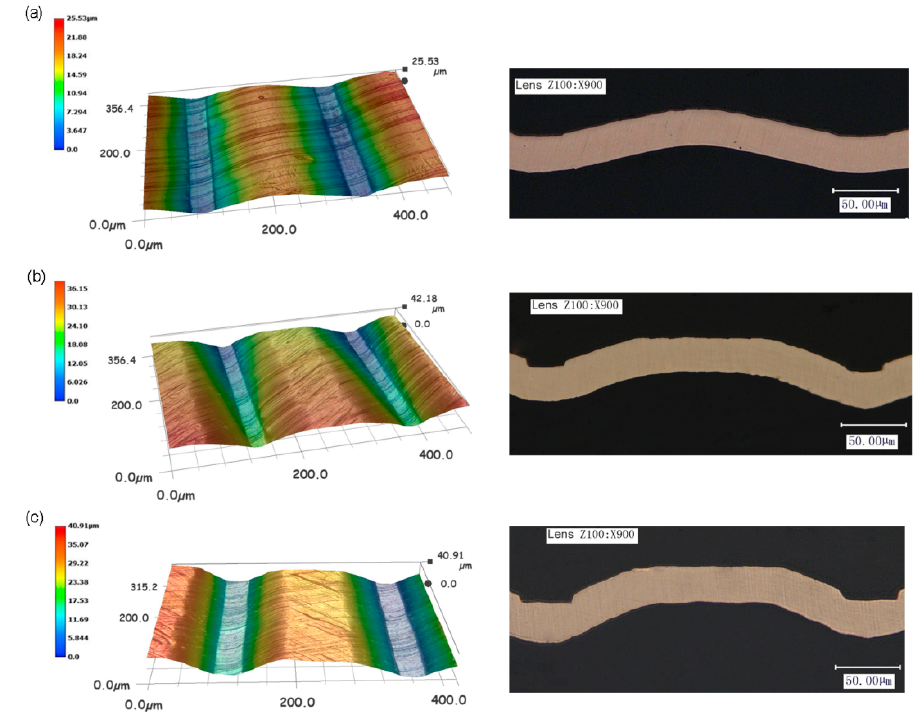
Figure 13. The 3-D morphologies and cross-section morphologies of the microchannel (channel 5) of the formed parts with the thickness of 30 µ m under different laser energy parameters: ( a ) under the laser energy of 565 mJ, ( b ) under the laser energy of 1200 mJ, and ( c ) under the laser energy of 1800 mJ.